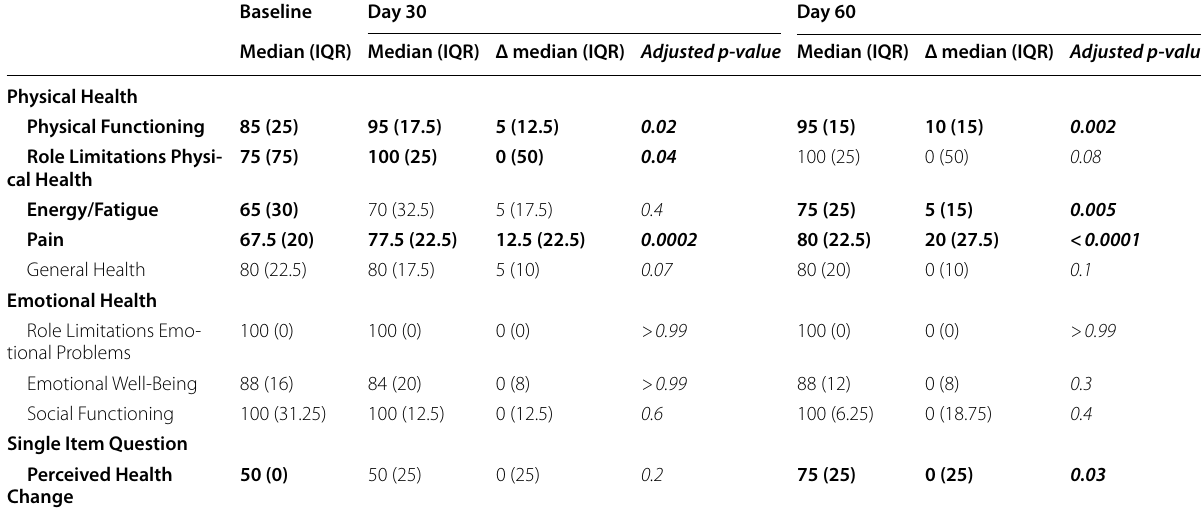
Data is represented by the median (interquartile range, IQR), n 29. Statistical analysis was performed using the non‑parametric Friedman test followed by Dunn’s = multiple comparisons post‑hoc test. p < 0.05 indicates statistical significance of the treatment from baseline